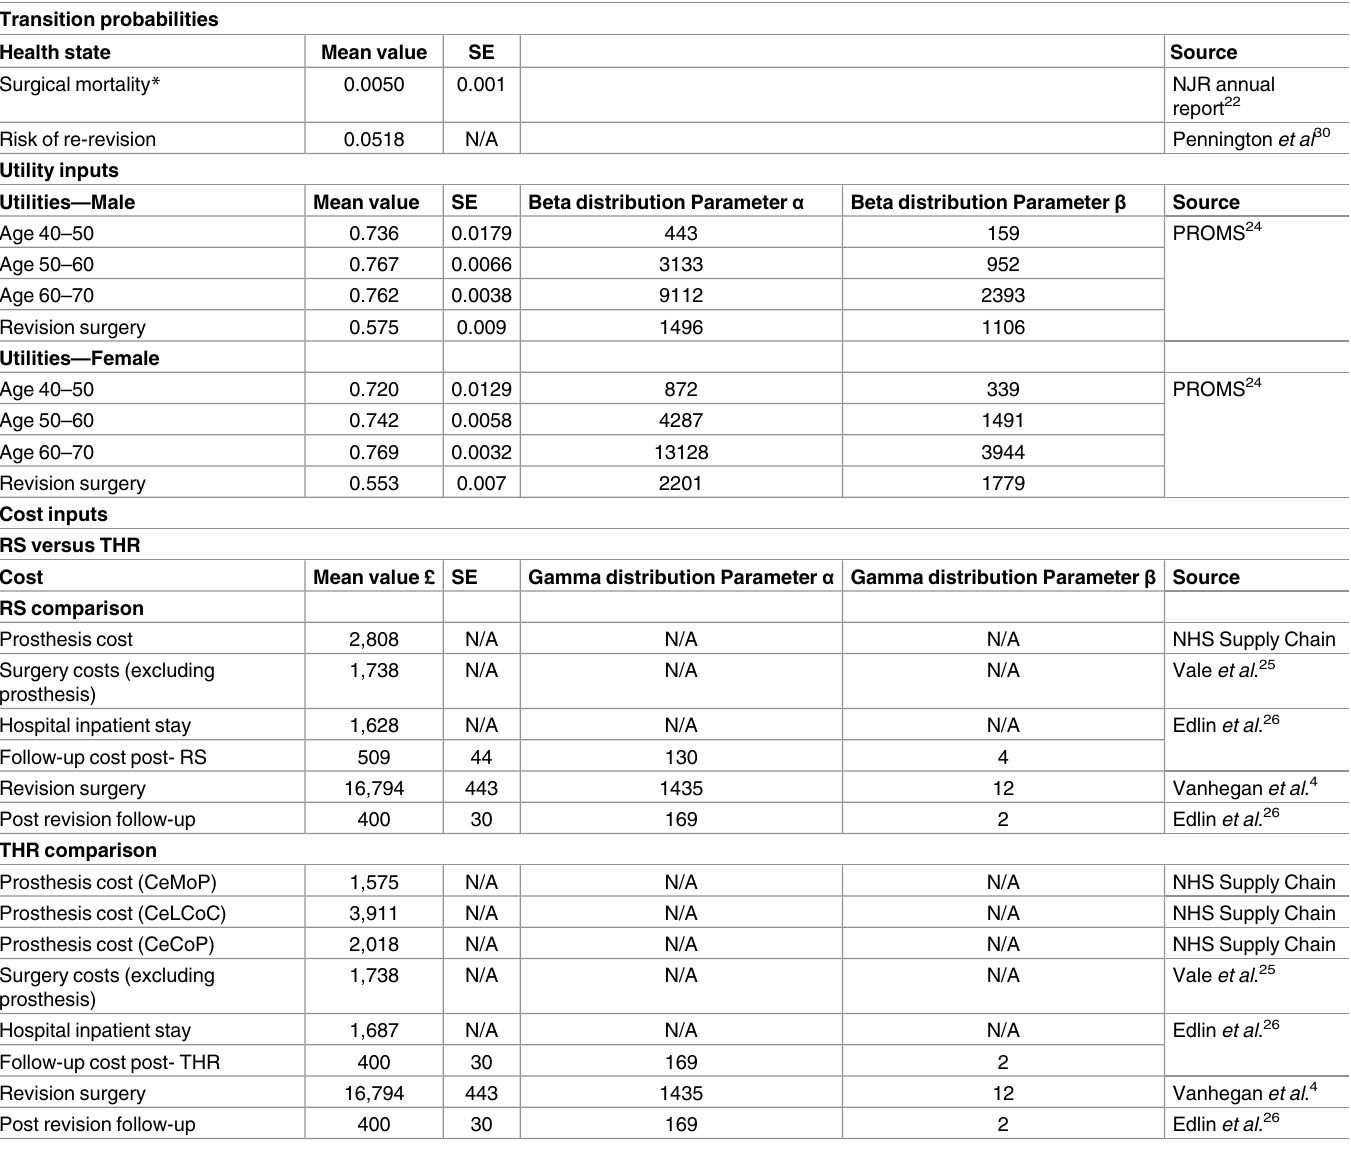
Table 1. Model inputs for the base case analysis of